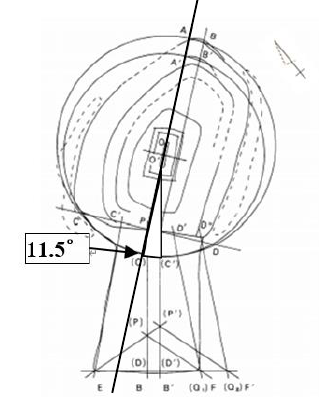
Fig.11 Mori Shogun zuka Kofun Design Planning Forecast